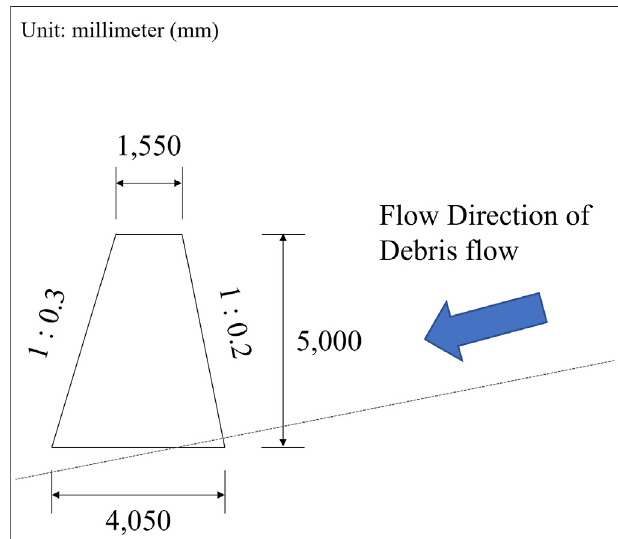
FIGURE 5 | Geometry of the central cross-section of the check dam. The height to crest is 5 m. The upstream face has a slope of 1:0.2, and downstreamface1:0.3.Thebasewidthis4.05 m,andthewidthatthecrestis 1.55 m.